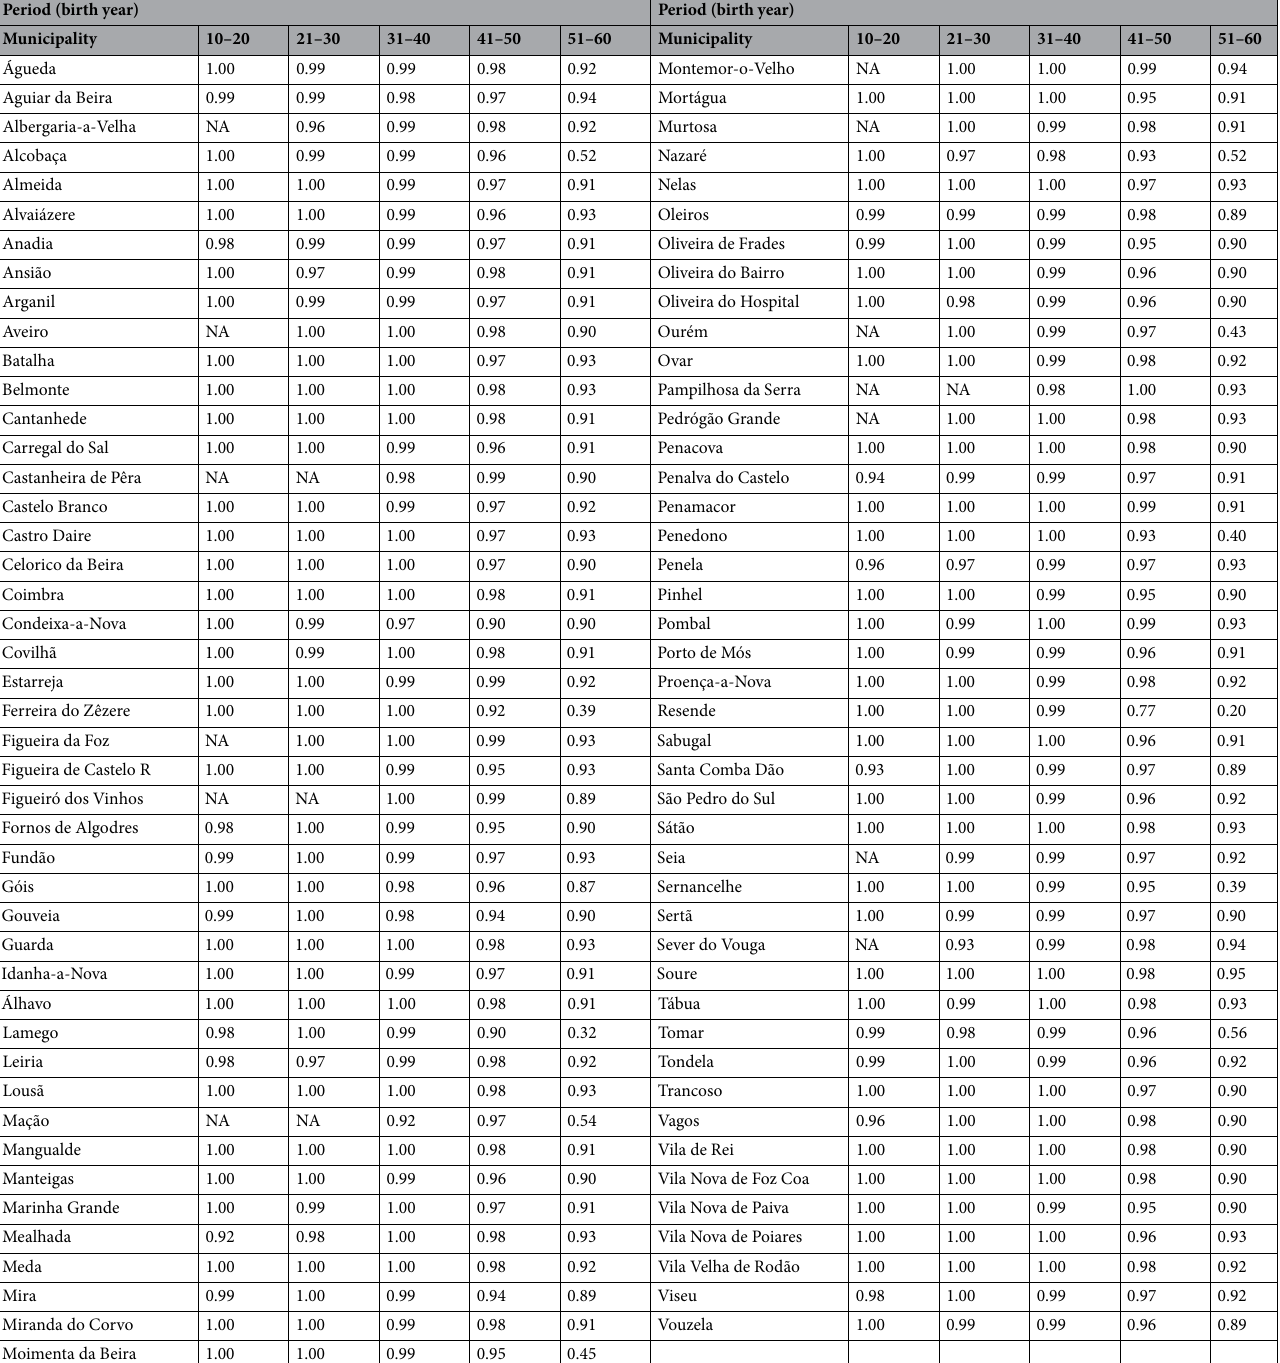
Figueira da Foz Figueira de Castelo R Figueiró dos